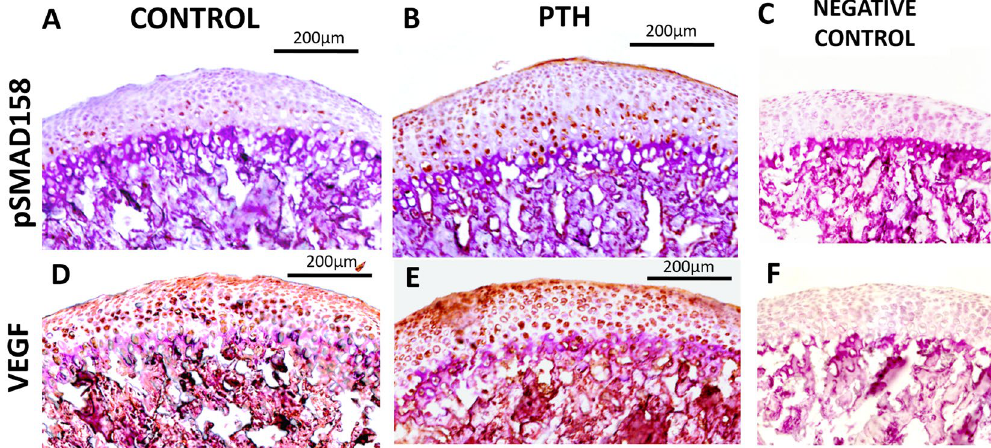
Figure 6. Increased expression of pSMAD158 and VEGF in the I-PTH group. Immunohistochemistry for pSMAD158 and VEGF in sagittal sections of the MCC and subchondral bone of control ( A ) and I-PTH ( B ) groups. ( C ) Negative control for pSMAD158 immunostaining. ( D ) Immunohistochemistry for VEGF in sagittal sections of control ( D ) and I-PTH ( E ) groups. ( F ) Negative control for VEGF